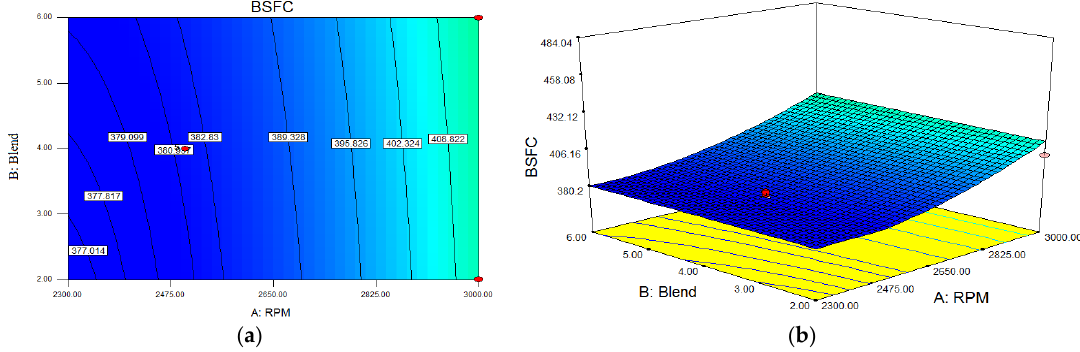
Figure 11. The interactive effect biodiesel and engine speed on the brake power. ( a ) 2D contour plots; and ( b ) 3D response surface plot.